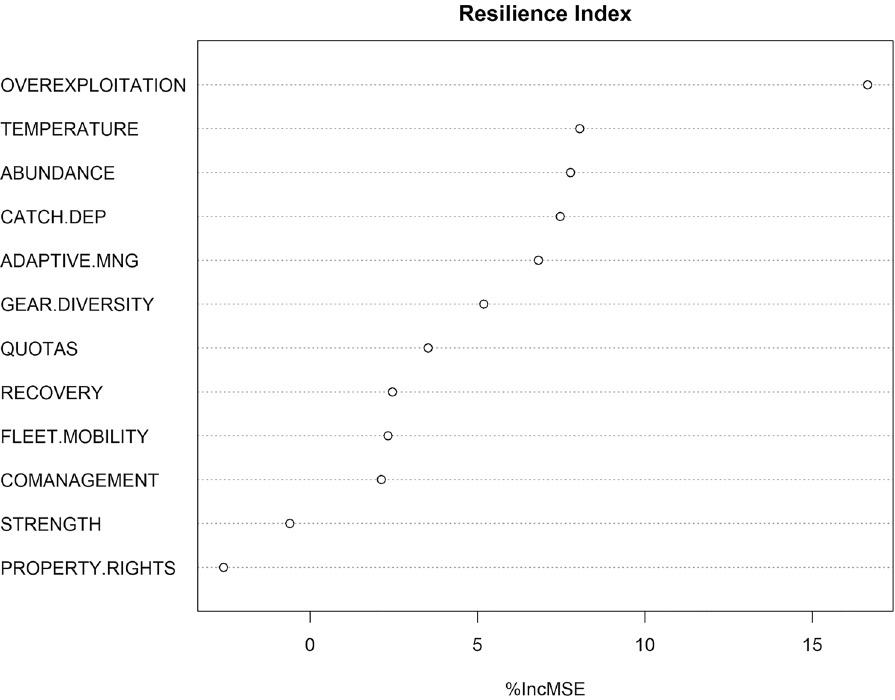
Figure 4. Random Forest results of the factors contributing to the resilience